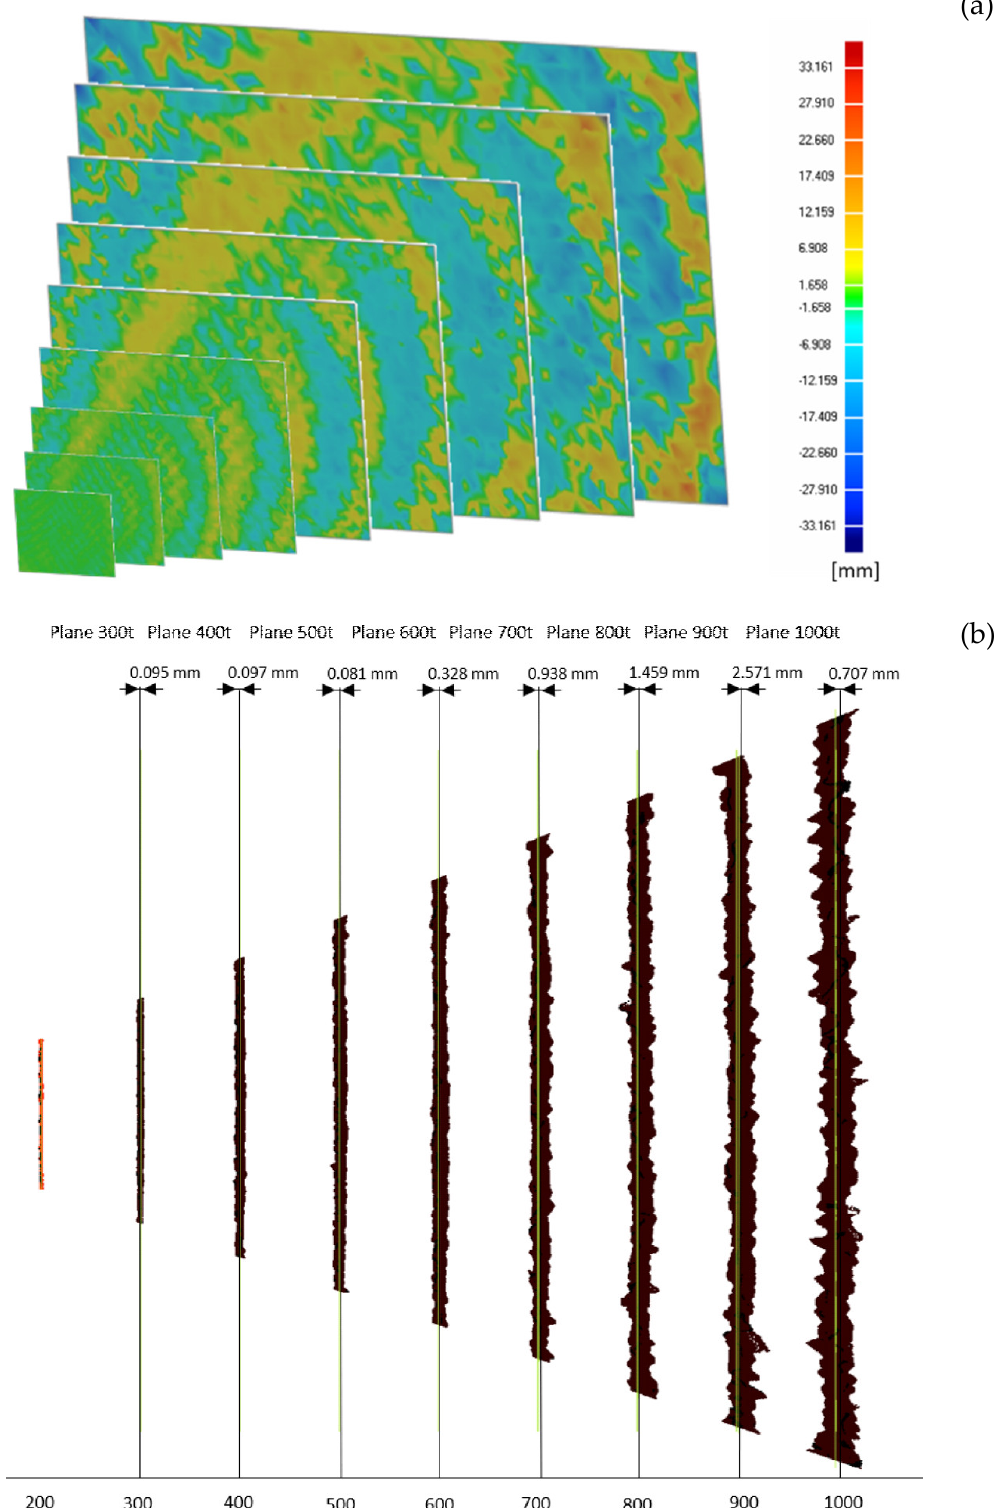
Figure 13. ( a ) The rrror map between the target plane and the 9 point clouds acquired using the D415 device with increasing distance from the plane itself. ( b ) Evaluation of the depth-offset error for the 9 acquired planes.